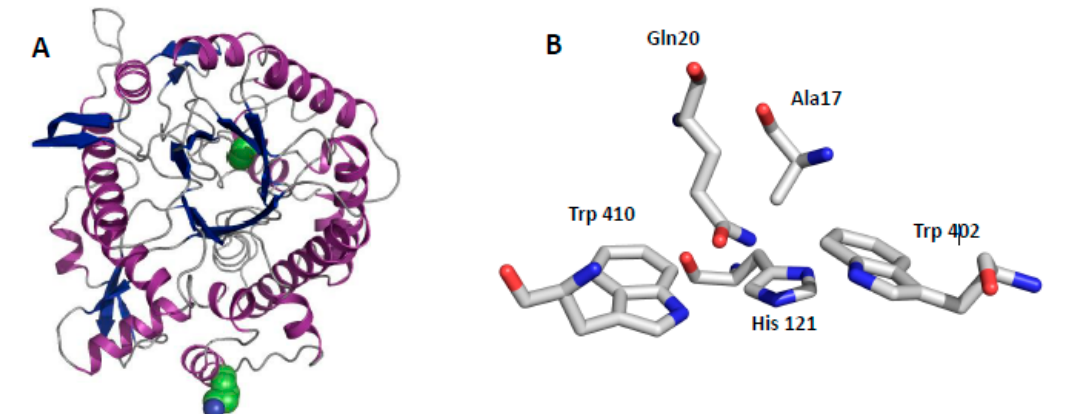
Figure 4. Structural analysis of C. thermocellum BglA. ( A ) Crystal structure of C. thermocellum BglA. α - Helices are colored purple. β -sheets are colored blue. Ala17 and Lys268 (the two mutated positions in Mut 1) are displayed by spheres. ( B ) Ala17 and its adjacent residues. Carbon atoms are shown in white, oxygen atoms in red and nitrogen atoms in blue. Analysis was performed using PyMol software.